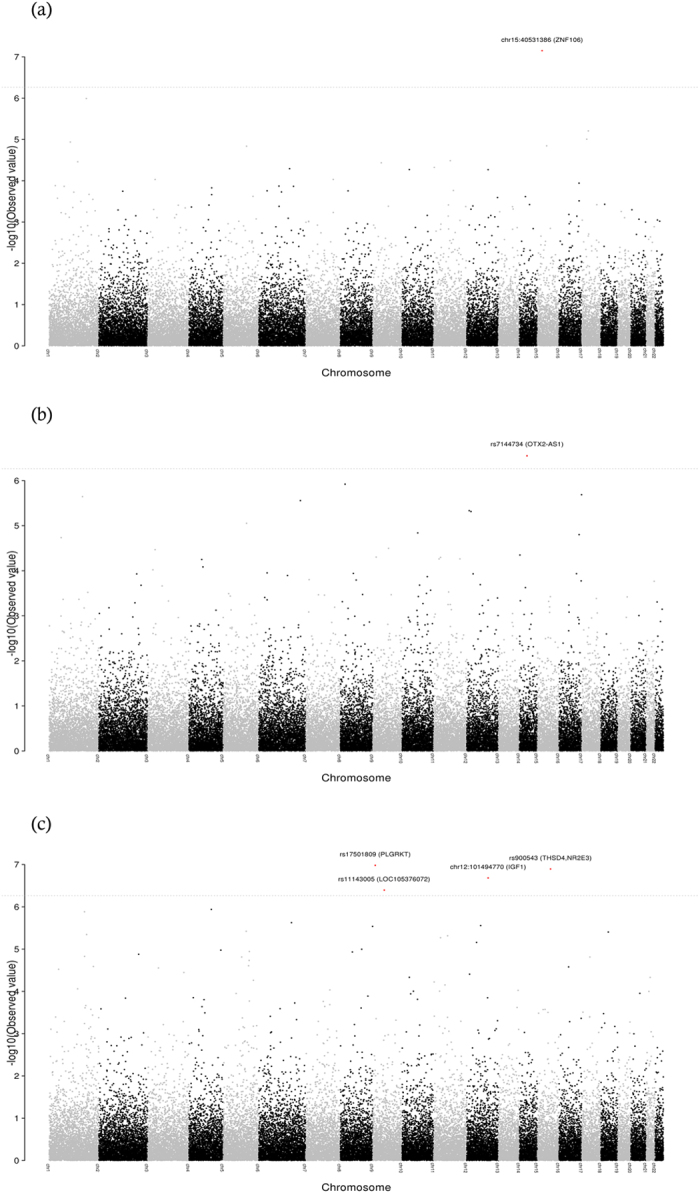
Manhattan plots of the 45793 tagSNPs employed to interrogate the genomes of the study population for associations with the phenotype traits of HbA1c (1.a), FPG (1.b), and TGL (1.c). The –log10 p-values were determined using linear regression methods adjusted for age, sex, first 10 principal components with respective quantitative trait. Labeled are those markers with a p-value of ≤ 5.45E-07.